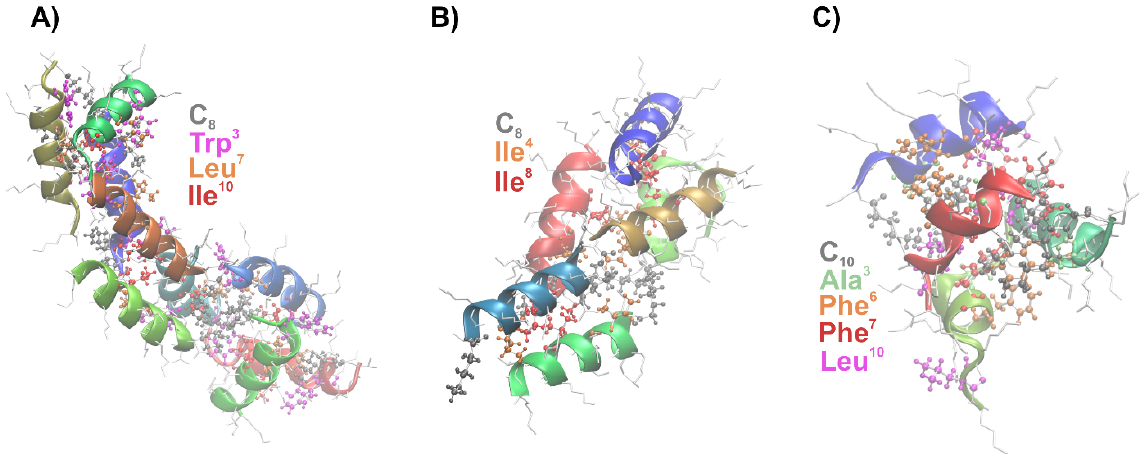
Figure 6. The largest oligomers extracted from the final snapshots of the 500 ns full-atom self- assembly simulations of ( A ) C 8 -LL-I, ( B ) C 8 -LK6 and ( C ) C 10 -ATRA-I. The backbone is represented as a ribbon model. The residues most often involved in hydrophobic interactions are presented in the ball-and-stick model.